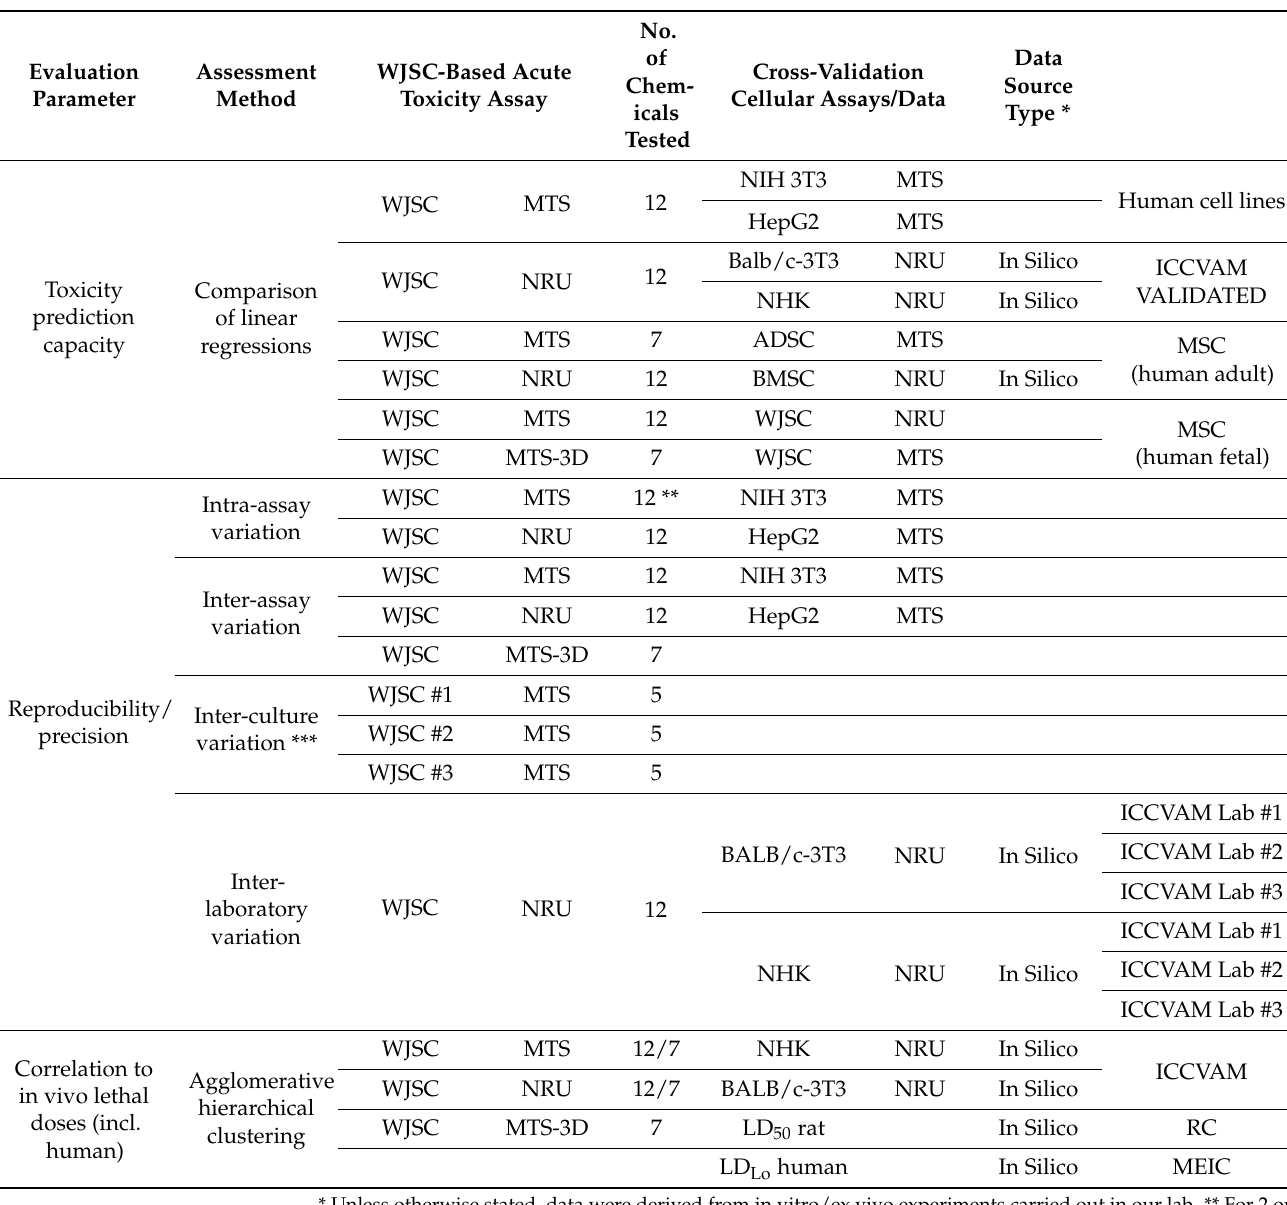
Table 2. Tabular overview of the experimental design employed for the evaluation of the WJSC-based acute toxicity